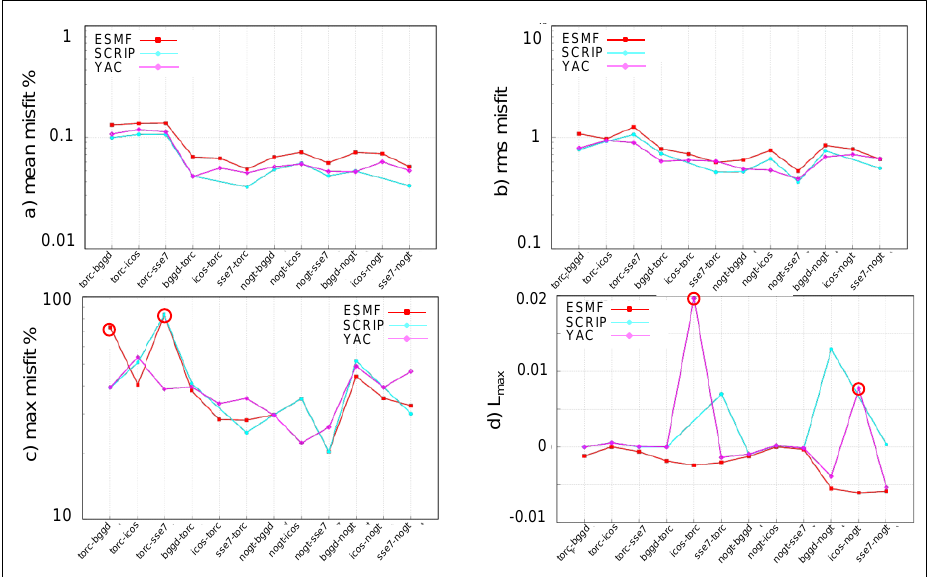
Figure 6. ( a ) mean, ( b ) rms, and ( c ) maximum misfit and ( d ) L max for the different pairs of grids for the gulfstream function for second-order non-conservative algorithms for ESMF, SCRIP and YAC. The red circles identify anomalous regriddings detailed in the